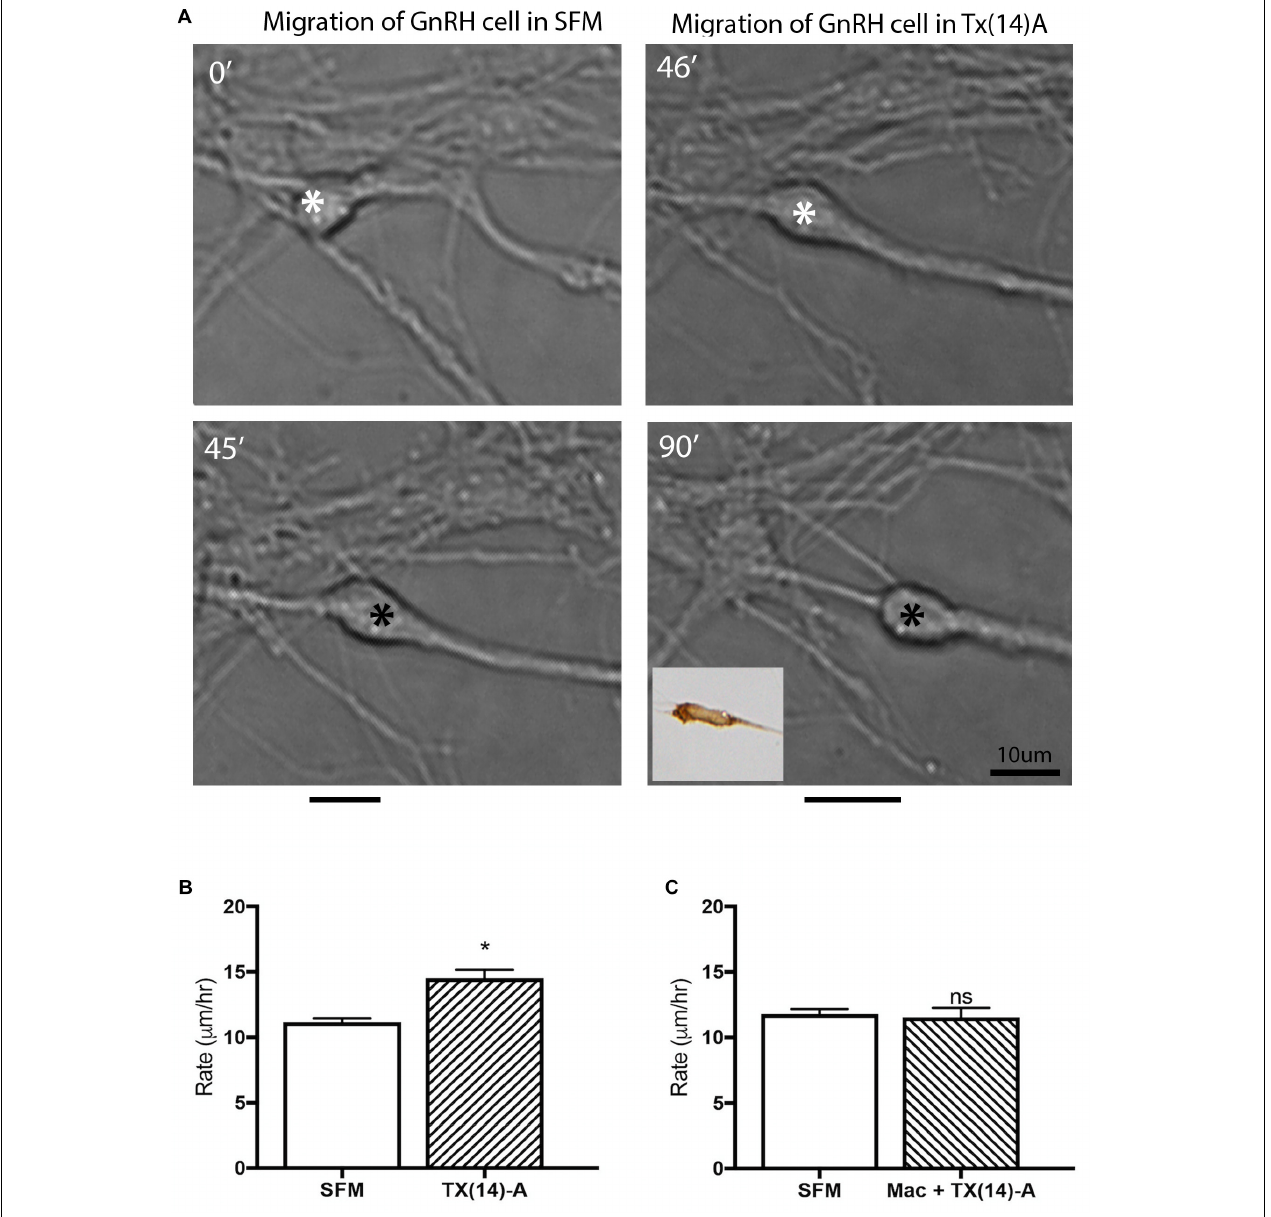
FIGURE 6 | Acute application of TX(14)A accelerates GnRH migration rate in nasal explants. (A) Example of acute assay showing GnRH cell in pre-treatment condition (SFM 45 min) and posttreatment condition (TX14A 45 min). Asterisk indicates location in cell soma where measurements were taken. Black lines beneath pictures indicate the distance moved during that 45 min treatment period. Phenotype of cell images was confirmed as GnRH post hoc via immunocytochemistry (inset). Scale bar: 1 µ m. (B) Histogram shows significant increase in migration rate of SFM/Tx14A ( N = 9 explants, n = 225 cells, p < 0.0001). (C) No change in migration rate was observed after application of Mac+TX14A ( N = 4 explants, n = 158 cells, p =